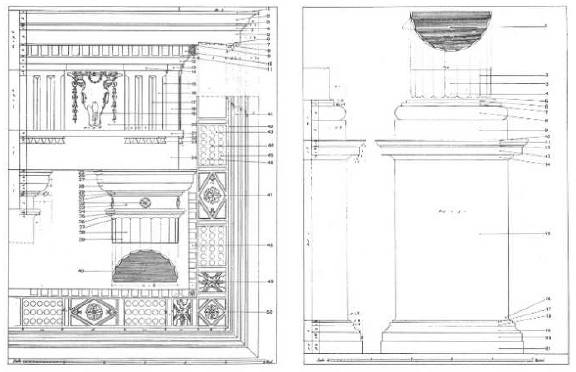
Figure 2. Entablature, column and pedestal in treatise. The images are from the text “Le membra degli ornamenti” (Morolli, 1986)